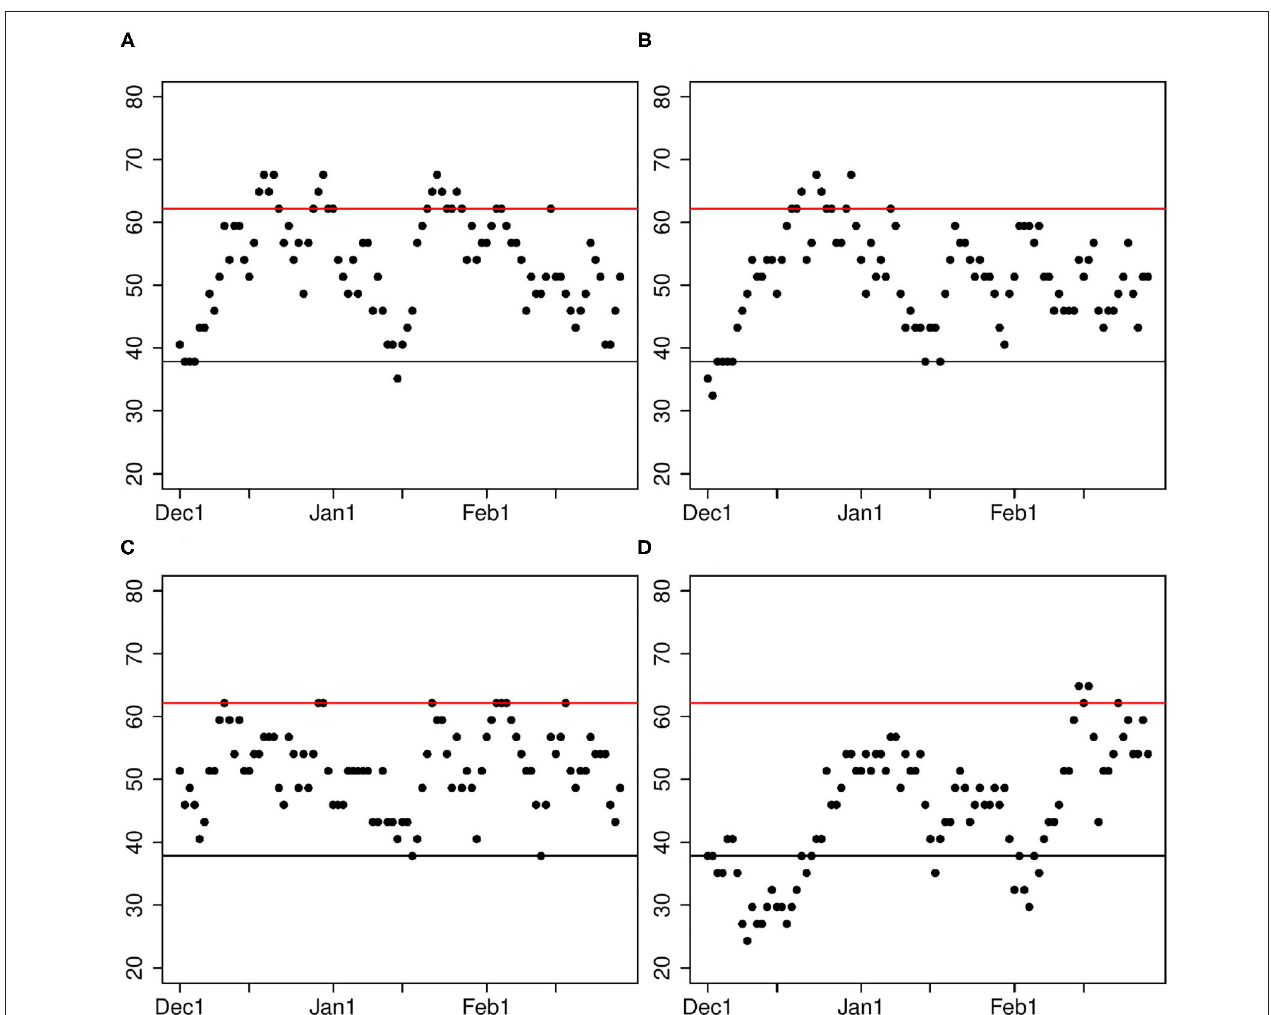
FIGURE 3 | Percentage of times ML predictions are closer to observations than predictions using the Nino3.4 index. The percentage is plotted as a function of the calendar day of the initial condition. Only predictions starting on the same calendar day are used to calculate percentages. For each calendar day, there are 37 predictions, one for each of the 37 years. The different panels show results for the following predictions: (A) Tropical Pacific Laplacians using lasso, (B) Tropical Pacific grid points using ridge, (C) Tropical Pacific grid points using lasso, (D) Atlantic plus Pacific Laplacians using lasso. Points above the red line indicate initial conditions when a prediction made with machine learning is significantly better (at the 5% level) than a prediction made with the Nino3.4 index. Points below the black line indicate initial conditions when predictions made with the Nino3.4 index are significantly better than predictions from ML. Panels (A,B) are both moderate improvements on the Nino3.4 index, (C) is statistically indistinguishable from the Nino3.4 index, and (D) is significantly worse than the Nino3.4